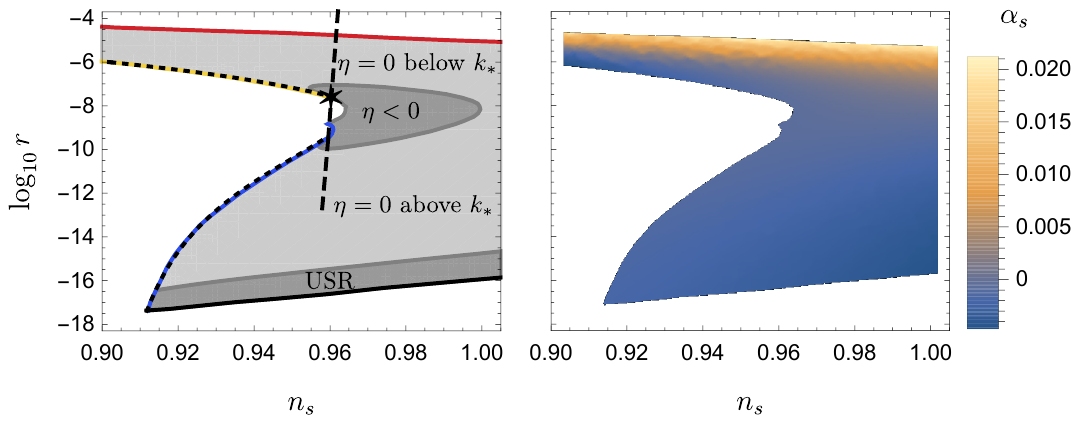
Figure 1 . Allowed points on the ( n s , r ) -plane with different regions of the parameter space marked (left) and values of α s shown (right), see explanation in the text. The allowed region continues to larger n s values on the right hand side and smaller n s values in the upper left corner. The dashed central line indicates the tree-level predictions with (2.14), (2.18) and (2.20), and requiring λ < 1 for perturbativity. At the point marked with a star, the potential does not have a feature and our results merge with the tree-level results not only for n s and r but also for α s and β s ; see discussion around equation